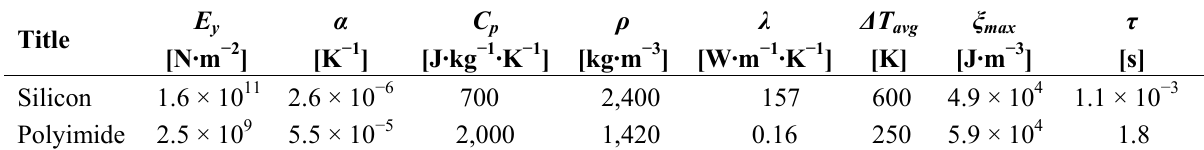
Table 2. Work density and response time of common materials in thermal expansion actuators